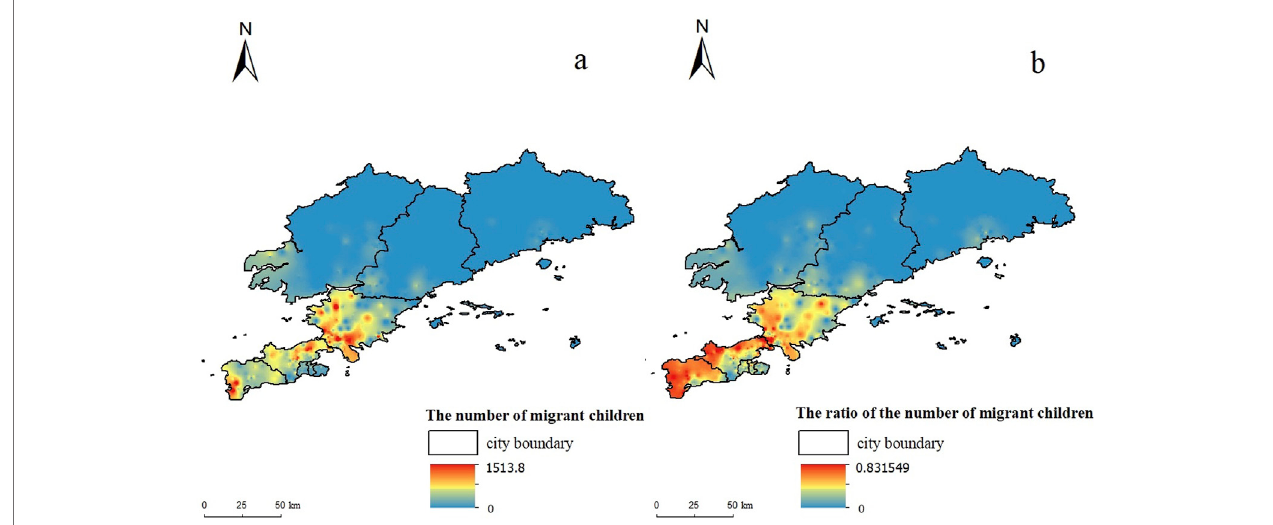
FIGURE 3 | Spatial distribution of the number (A) and proportion of migrant children (B) in Dalian from 2008 to 2020.